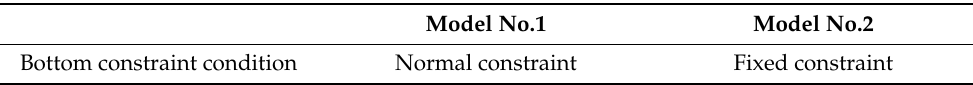
Table 7. Different boundary condition models.